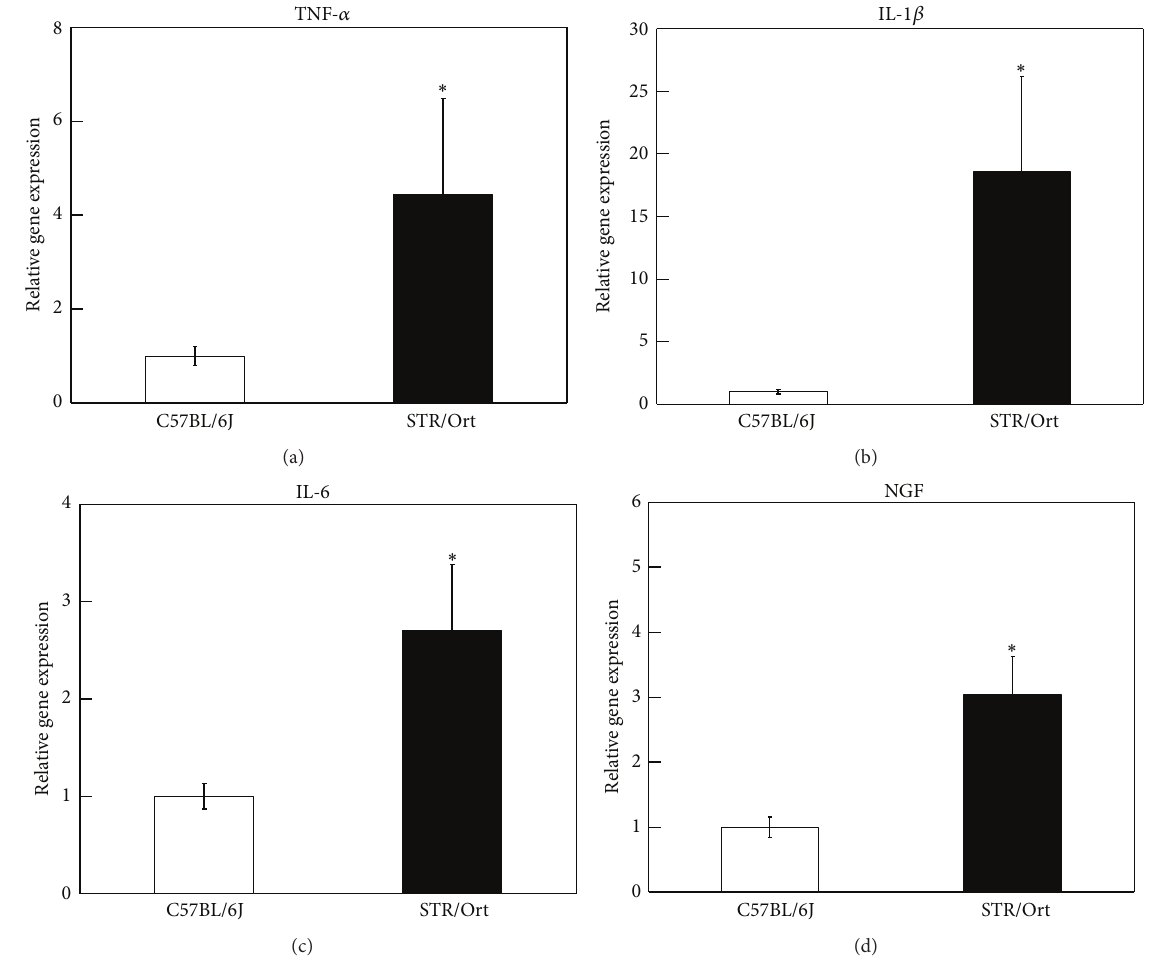
Figure 1: Real-time PCR analysis for the gene expression of TNF- 𝛼 , IL-1 𝛽 , IL-6, and NGF in synovial tissues (a–d) of C57BL/6J and STR/Ort mice. ∗ indicates a statistically significant difference between C57BL/6J and STR/Ort mice. All data are presented as the mean ± SE ( 𝑛 = 10 ).